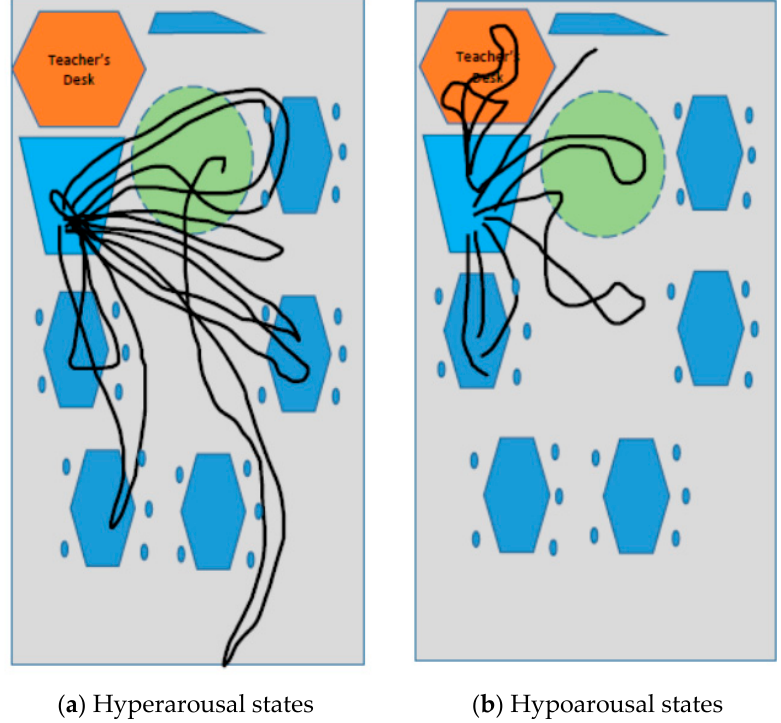
Figure 11. Rhythmanalysis and diagramming Ted’s “wander lines” and movement in the classroom to show affect attunement between him and the children in shared arousal states. (a) Hyperarousal states and (b) Hypoarousal states.